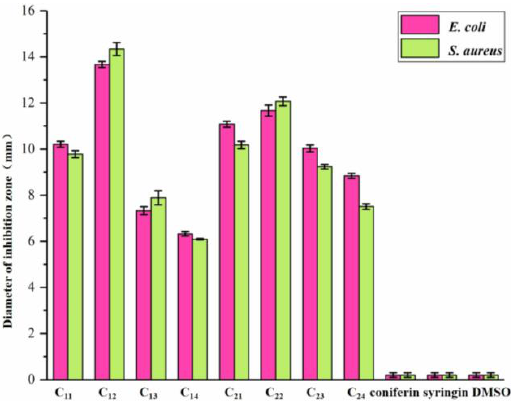
Figure 4. Inhibitory effect of DHP fractions on the growth of S. aureus. Legend: The red circle area is the inhibition zone; coniferin and syringin: precursors of DHP; DMSO: No sample was added, only DMSO was added; control: control group without sample and solvent.